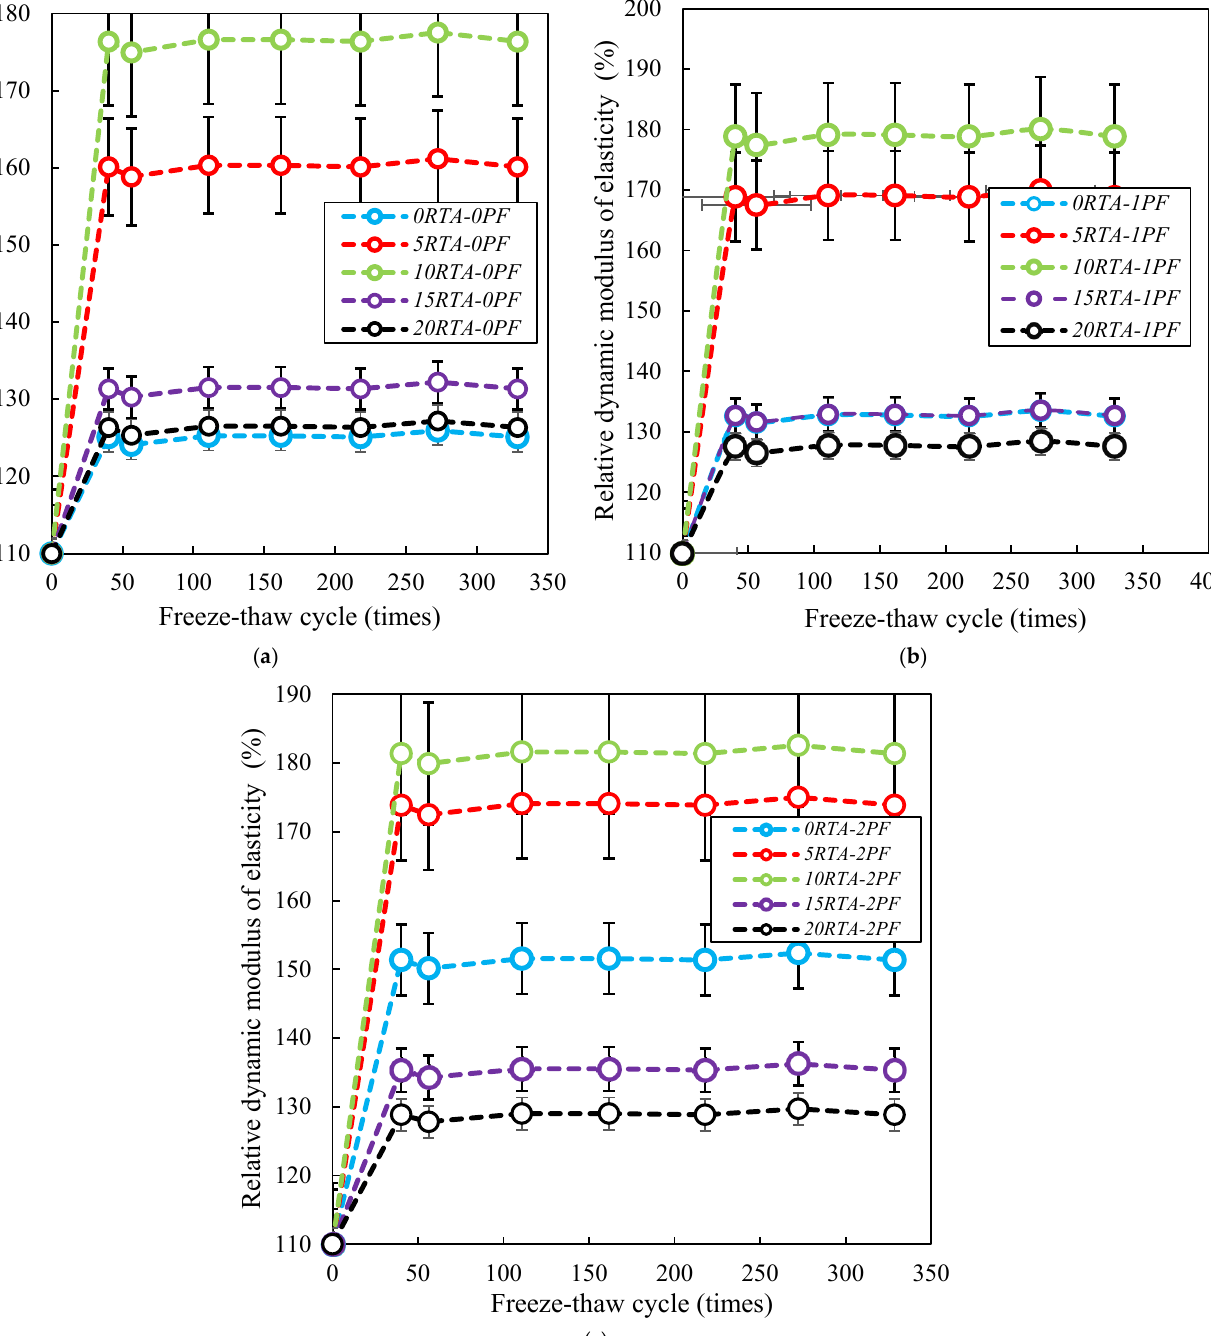
Figure 20. Dynamic elastic modulus of concrete having PF and RTA. ( a ) without PF, ( b ) with 1% PF and ( c ) with 2% PF